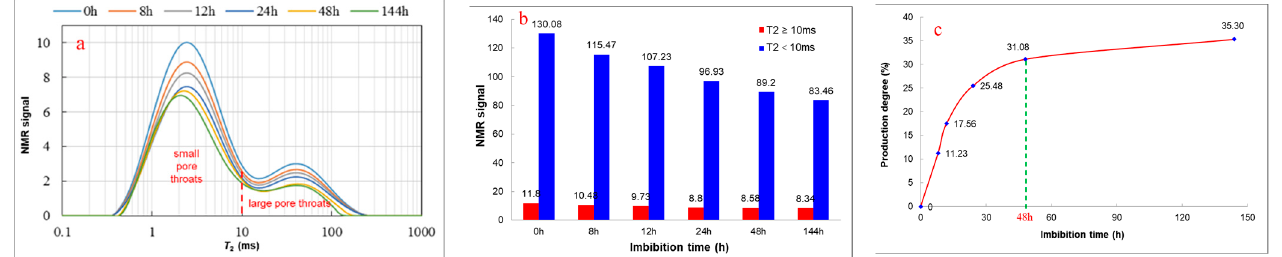
Figure 14. Imbibition NMR results of core samples of the type III reservoir; ( a – c ) are the T 2 spectrum of imbibition NMR, the histogram of NMR signals at different imbibition times and the variation in the production degree of crude oil in the pore throats of IR-02, respectively.